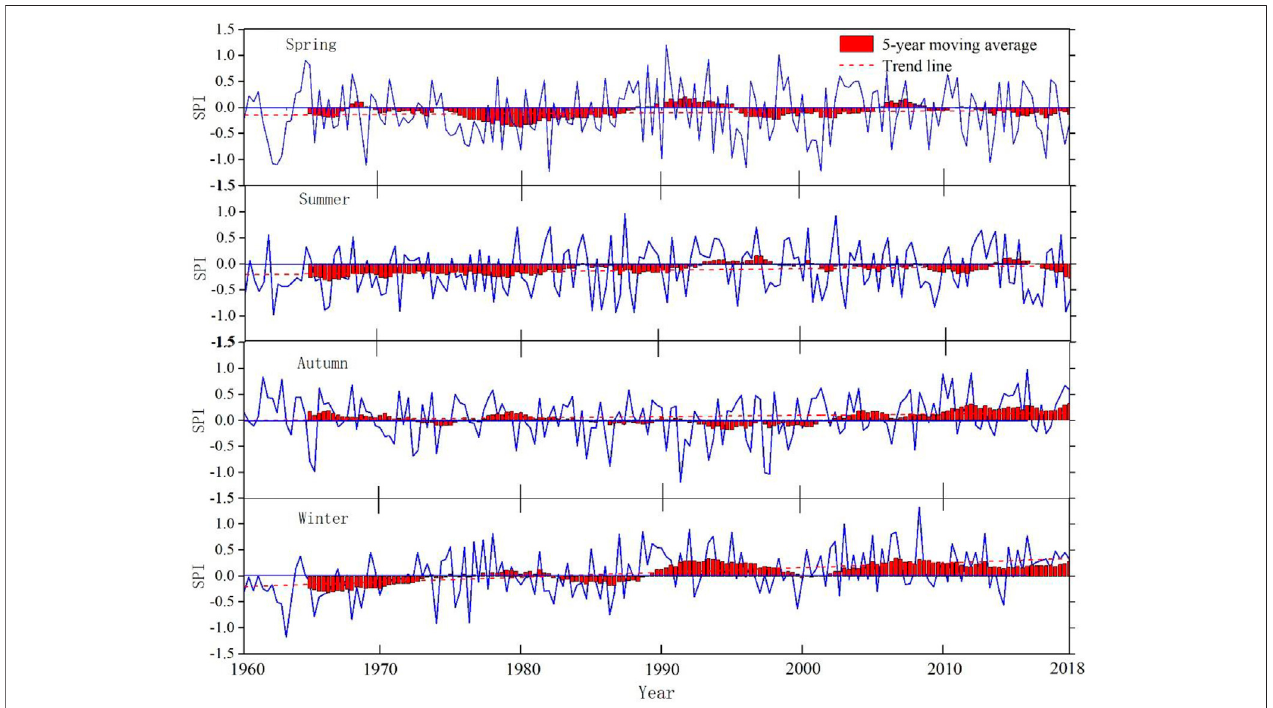
FIGURE 4 | Variation of seasonal SPI series from 1960 to 2018 in